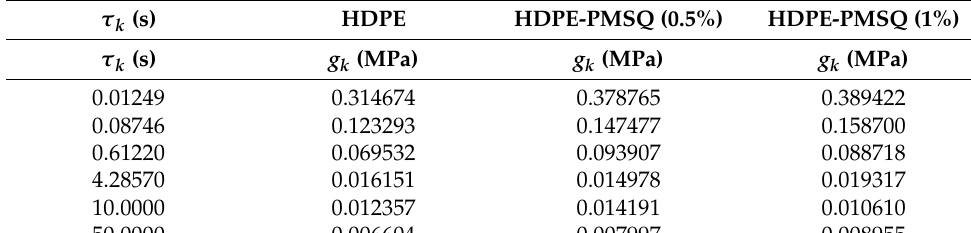
Table 4. Stiffness modulus and relaxation time for the composites at T = 160 ◦ C.